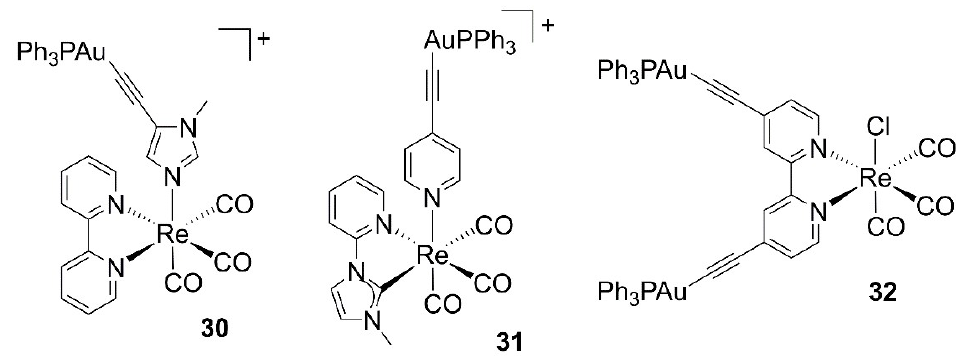
Figure 6. Structures of heteronuclear gold–rhenium anticancer complexes.